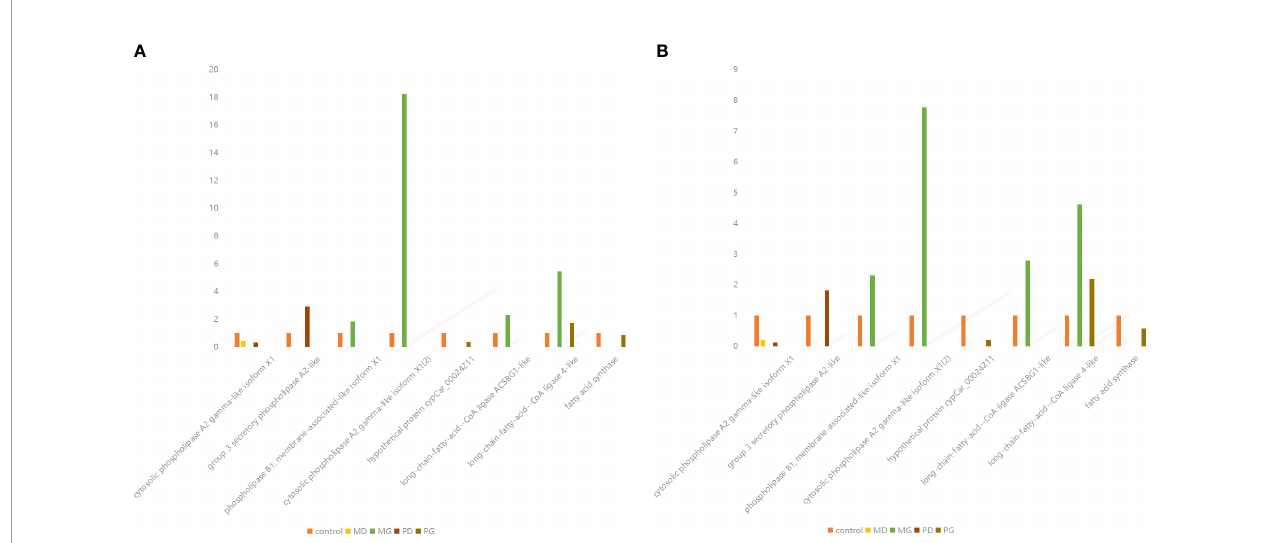
FIGURE 7 | Comparison of qpcr veri fi cation results with transcriptome analysis results. (A) Quantitative reverse transcription PCR (qRT-PCR) veri fi ed the relative expression of differentially expressed genes in Ctenopharyngodon Idella brain. Gene names are presented on the abscissa, and fold change values are presented on the ordinate. (B) Relative expression of differentially expressed genes (DEGs) in in Ctenopharyngodon idella brain obtained by RNA-Seq. Gene names are presented on the abscissa, and fold change values are presented on the ordinate.